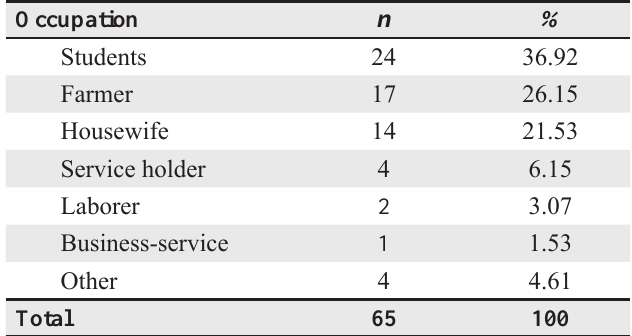
Table 1 : Occupation of the patients